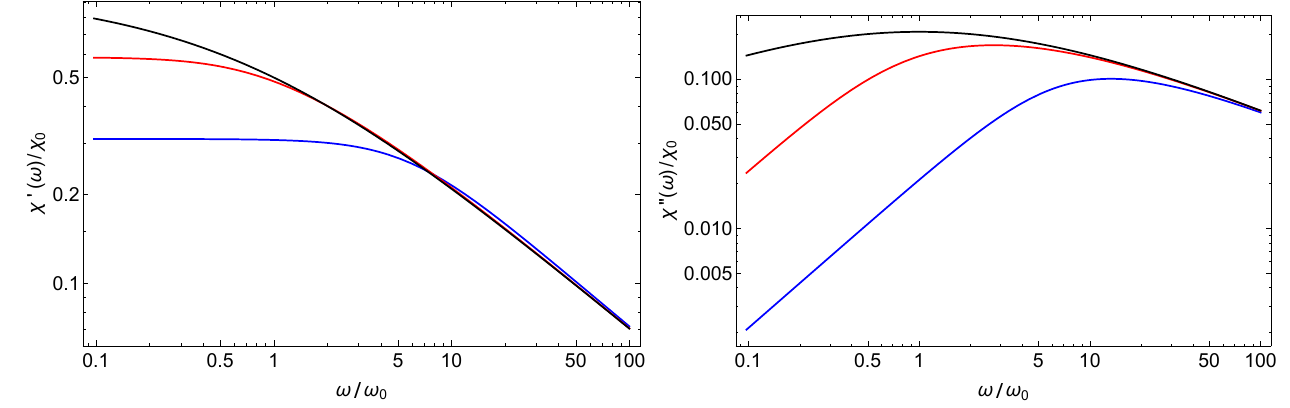
Figure 7. Behaviour of the complex susceptibility (log–log plot) for Cole–Cole relaxation with resetting. The black lines correspond to Debye relaxation without resetting, while the red and blue lines correspond to r -parameter values of 0.5 and 5, respectively. The parameter α = 0.5. Left panel : real part. Right panel : imaginary part (dielectric